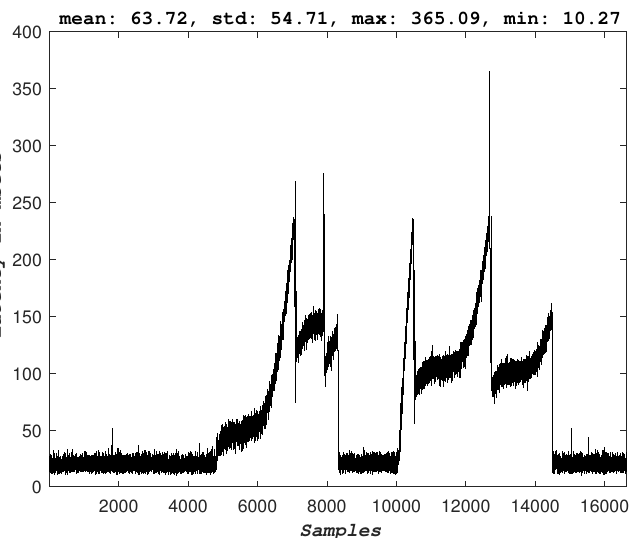
Figure 7. The uplink latency of the 5G-UAV. Sensor offloading on the same 5G-UAV platform is turned on and off two